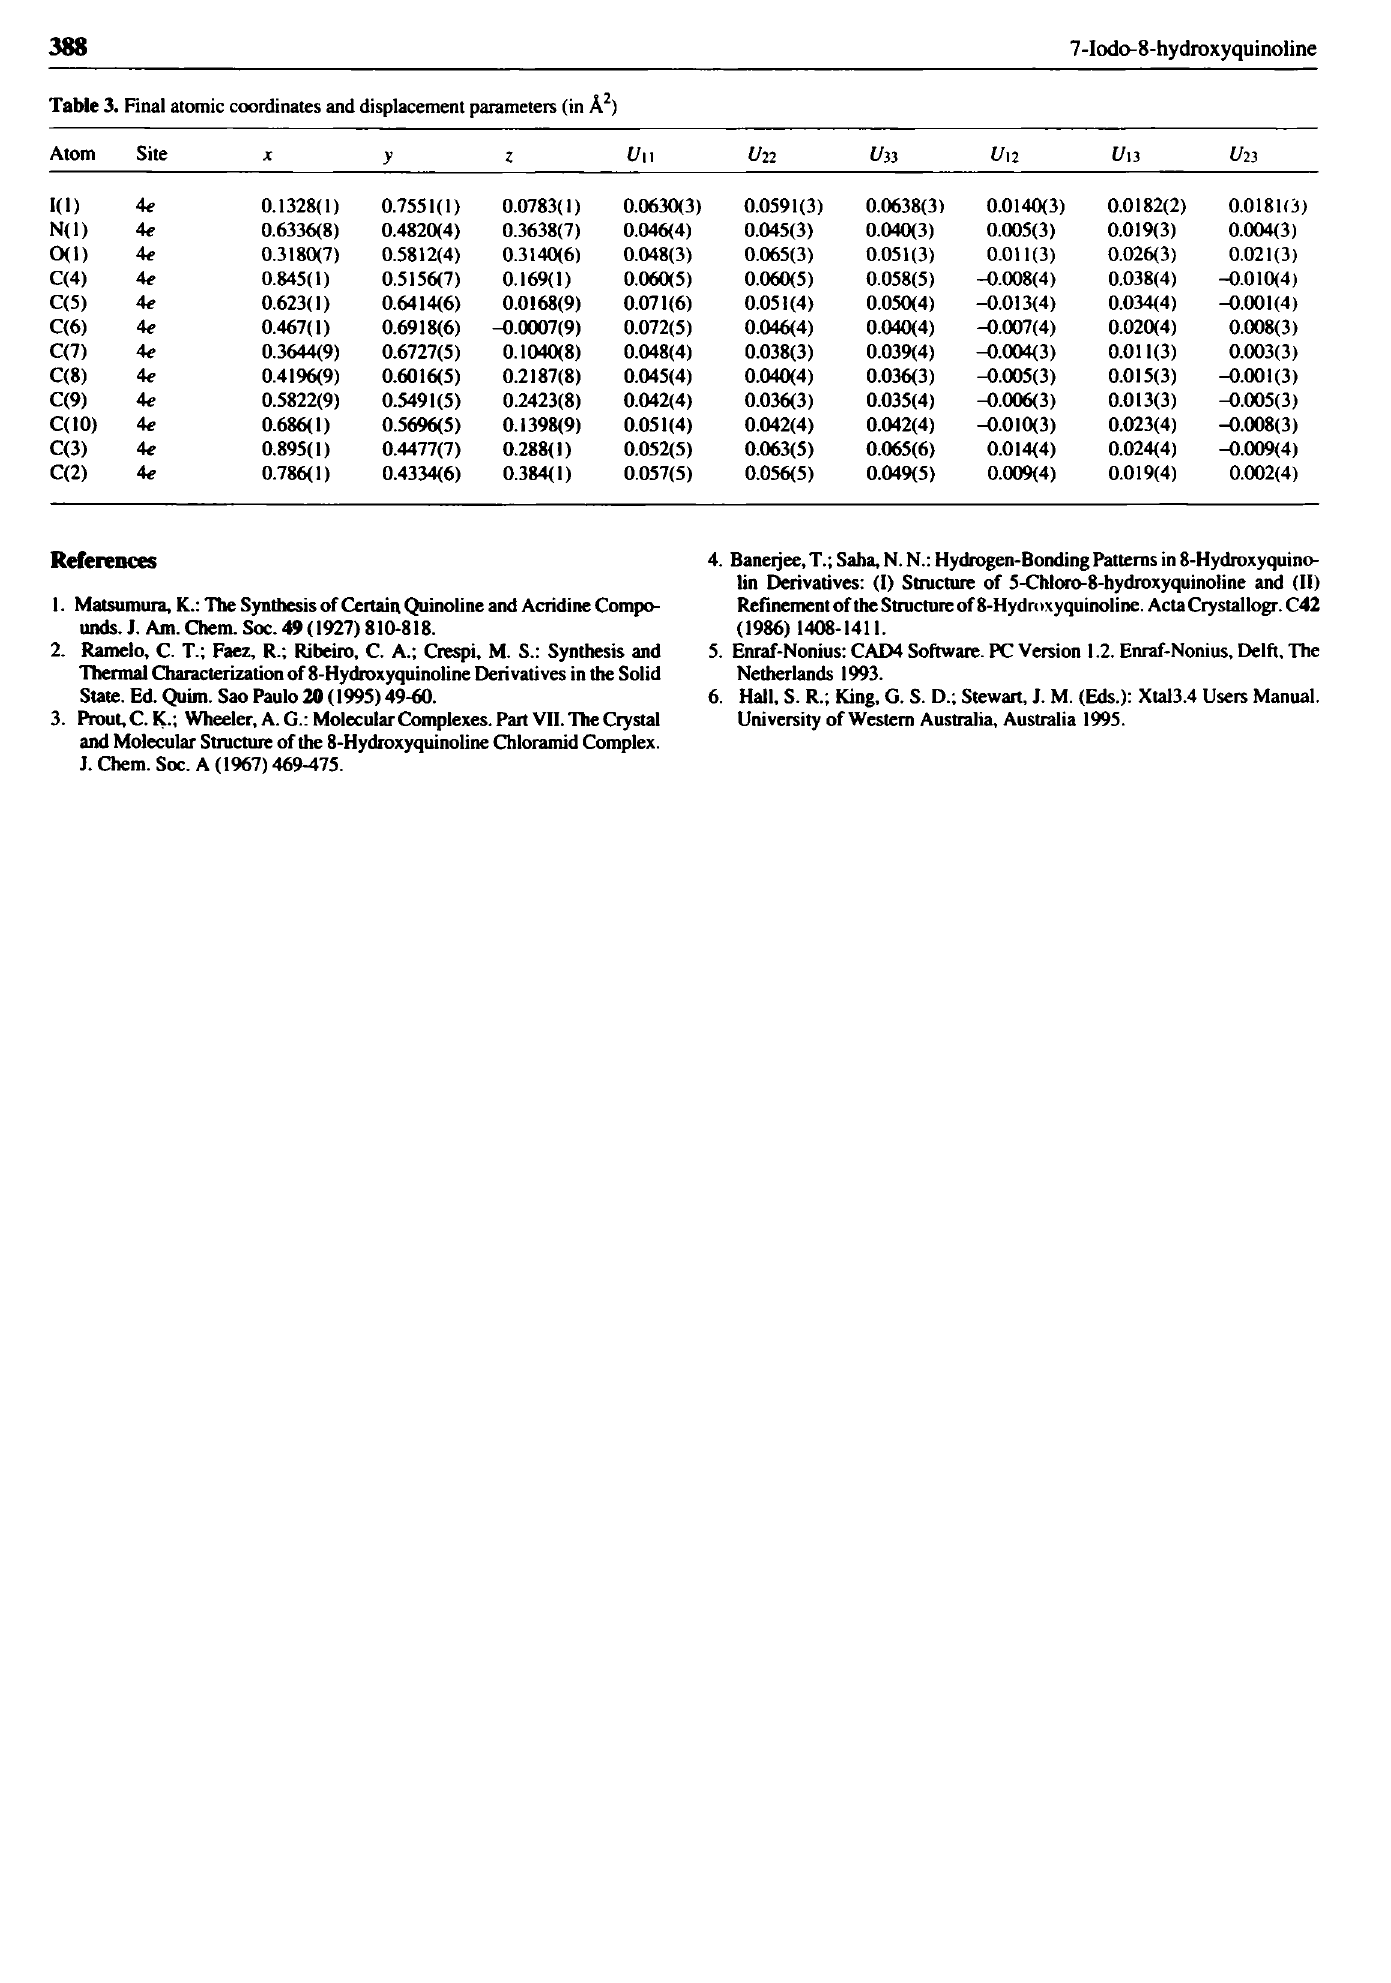
Table 3. Final atomic coordinates and displacement parameters (in Â 2